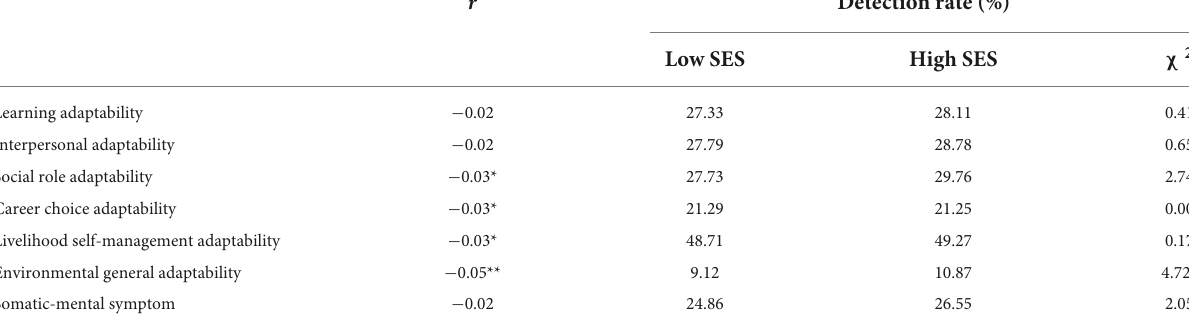
TABLE 4 The relations between primary study variables and socioeconomic status